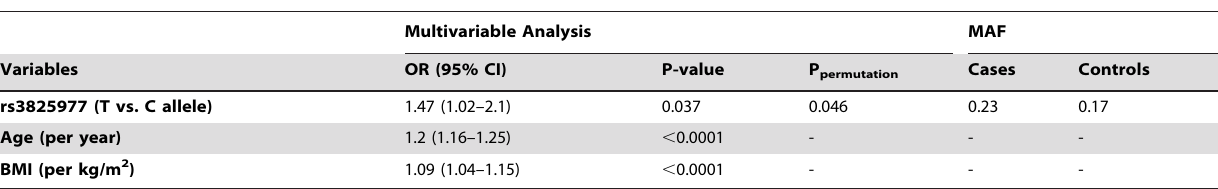
Table 3. Association between GOA and